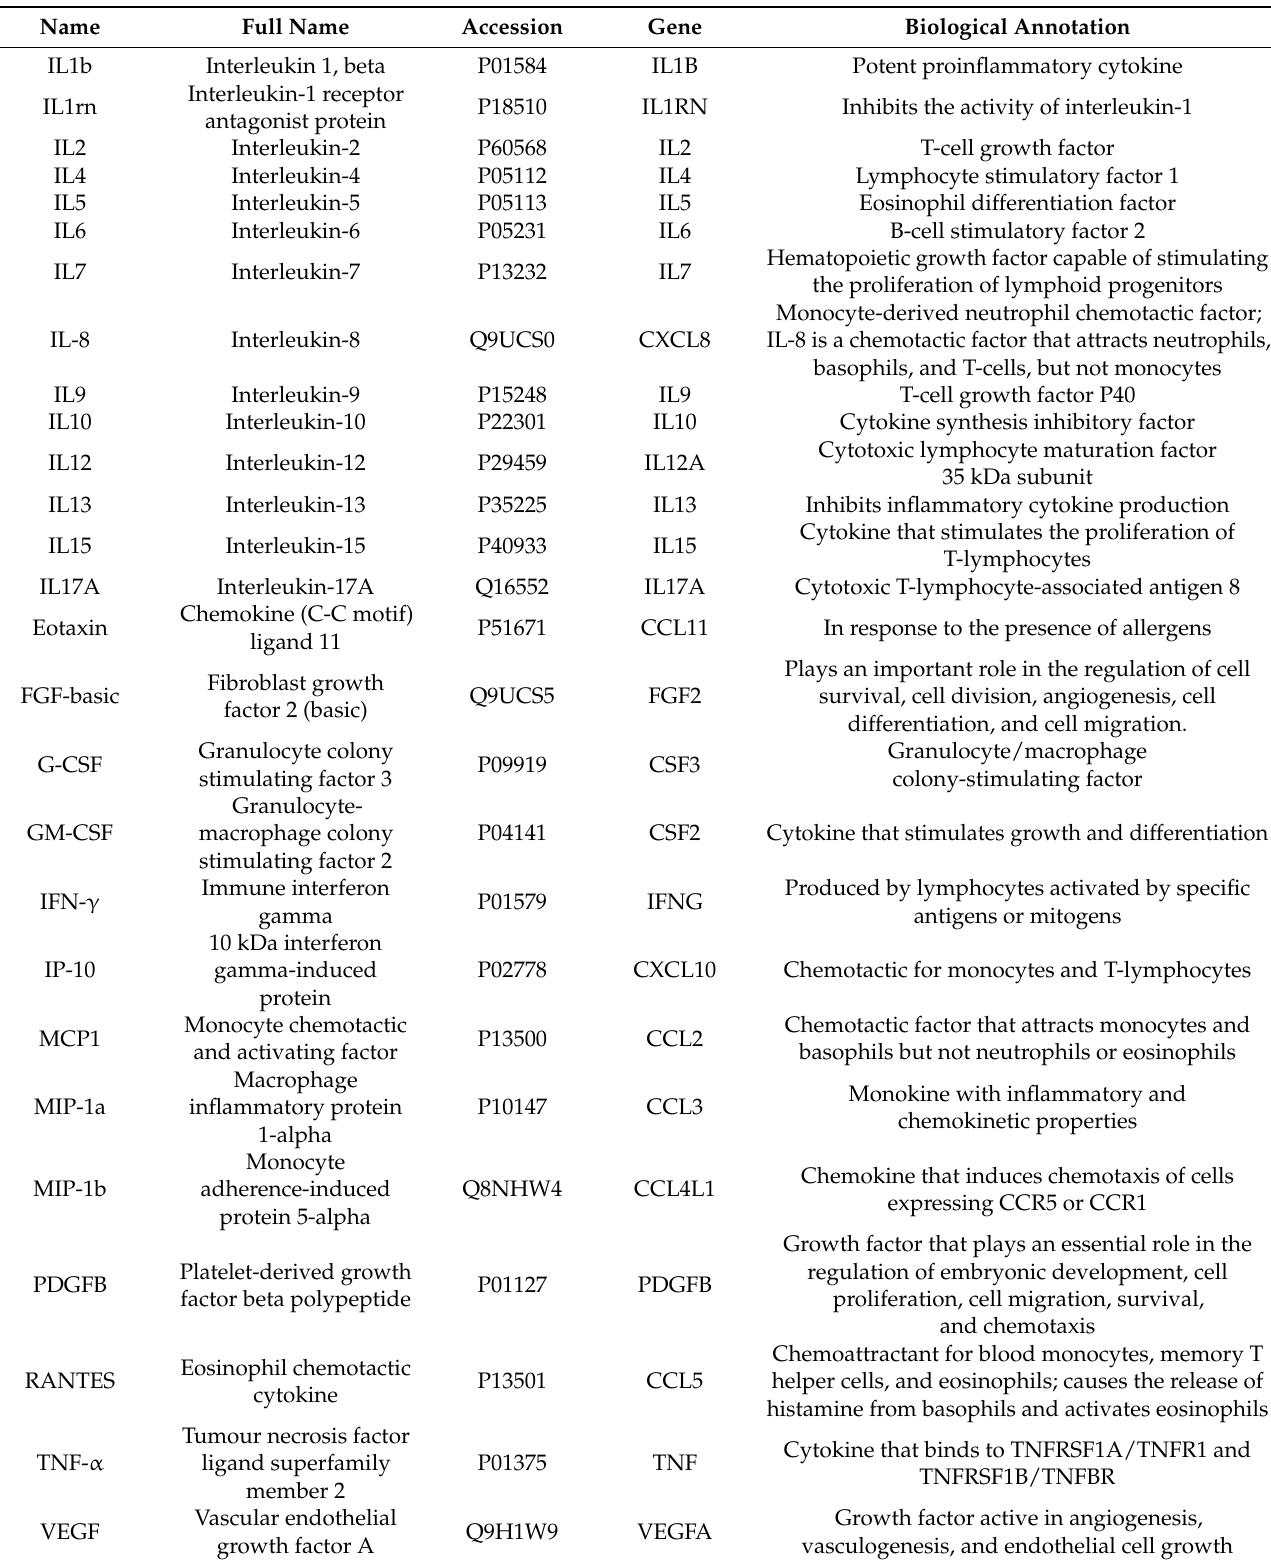
Table 1. Biological annotation for cytokines and